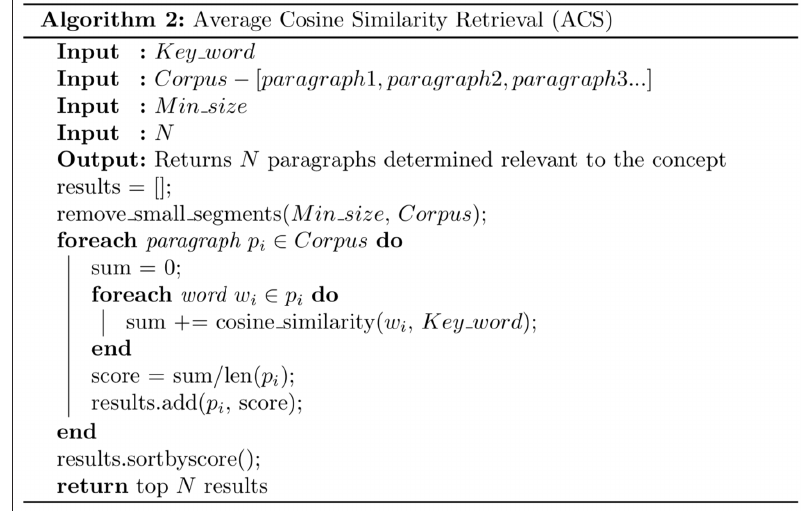
Figure 3: ACS Retrieval